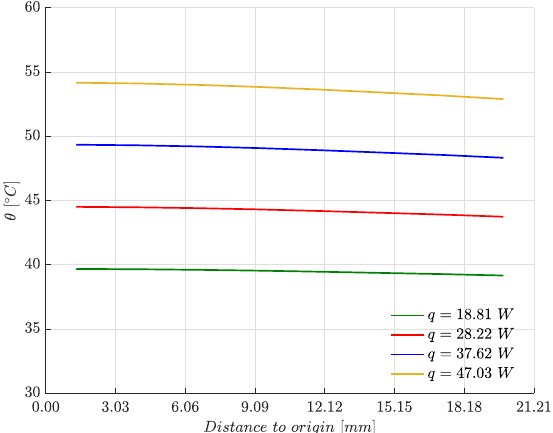
Figure 19. Temperature distribution at the nodes located at the diagonal of the base of the micropro- cessor for: q = 18.81W, q = 28.22W, q = 37.62W and q =